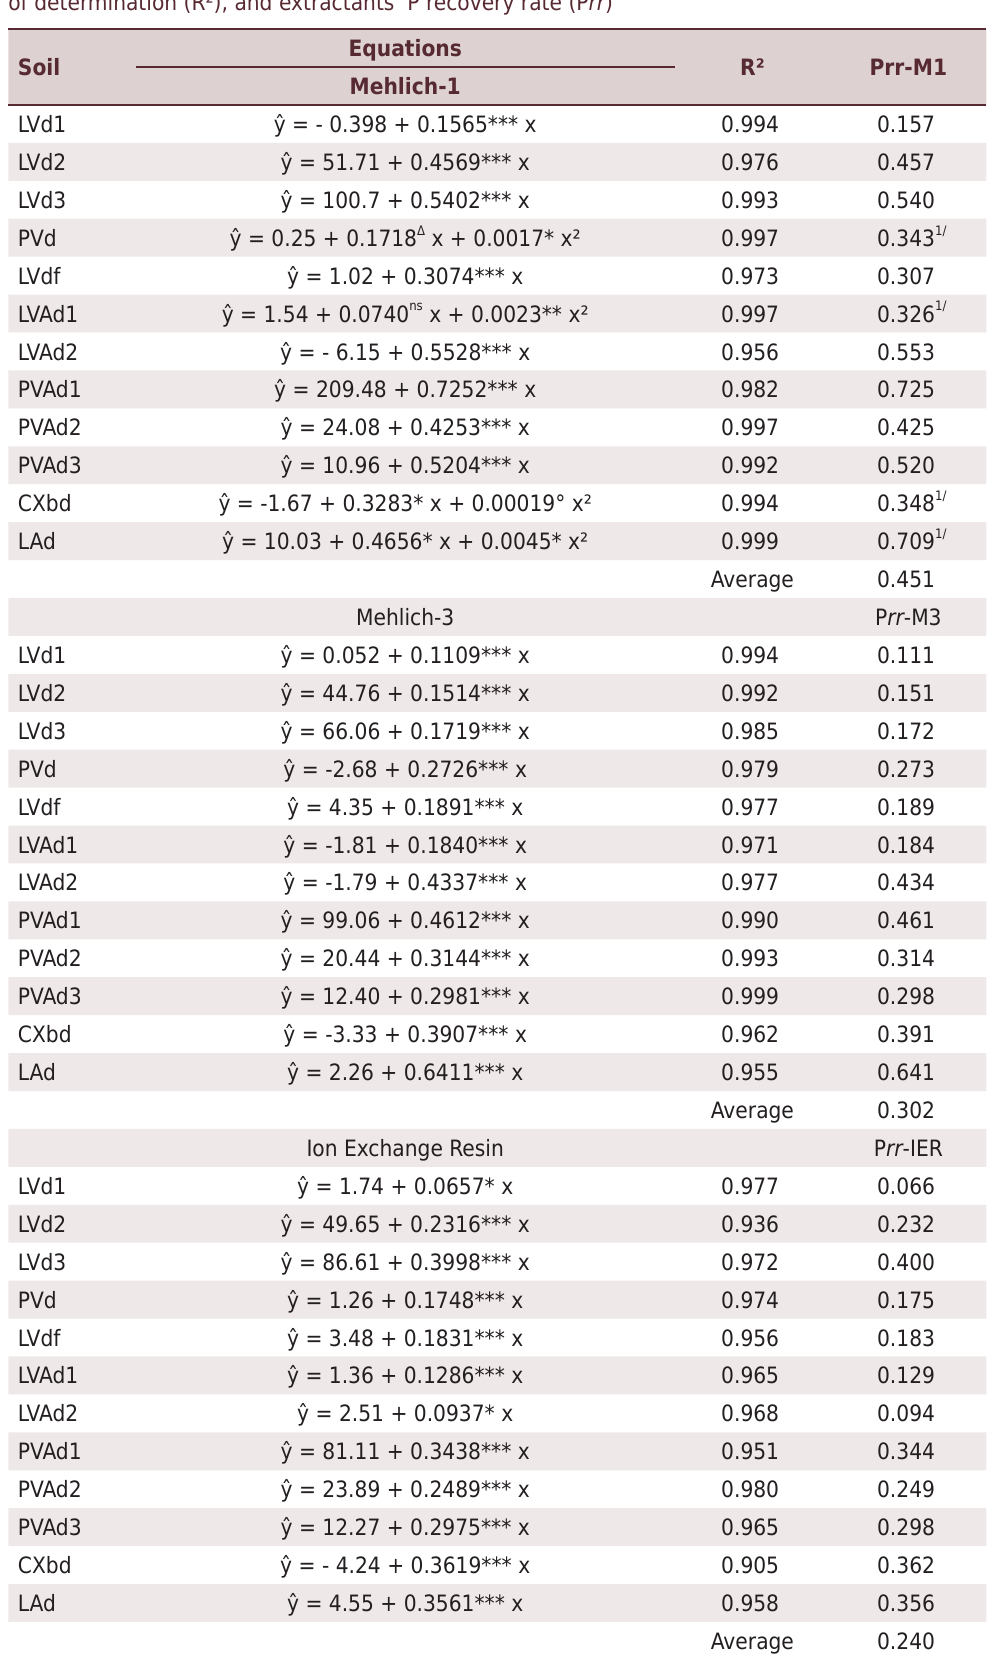
Table 3. Equations of the recovered P contents by Mehlich-1 (M1), Mehlich-3 (M3), and Ion Exchange Resin (IER) (ŷ, mg dm -3 ), according to the doses of P (x, mg dm -3 ) applied to each soil, coefficient of determination (R²), and extractants’ P recovery rate (P rr